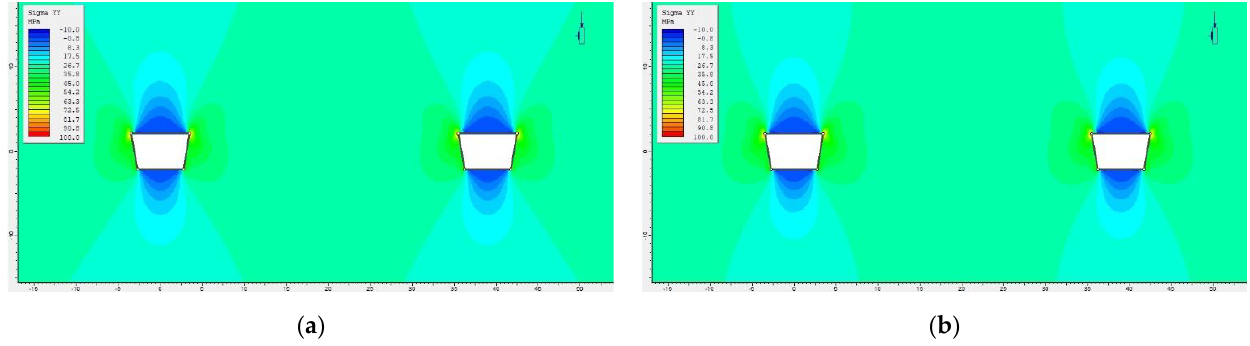
Figure 4. Distribution of σ YY stresses in the cross-section through ramps drilled in: ( a ) sandstone; ( b ) dolomite.